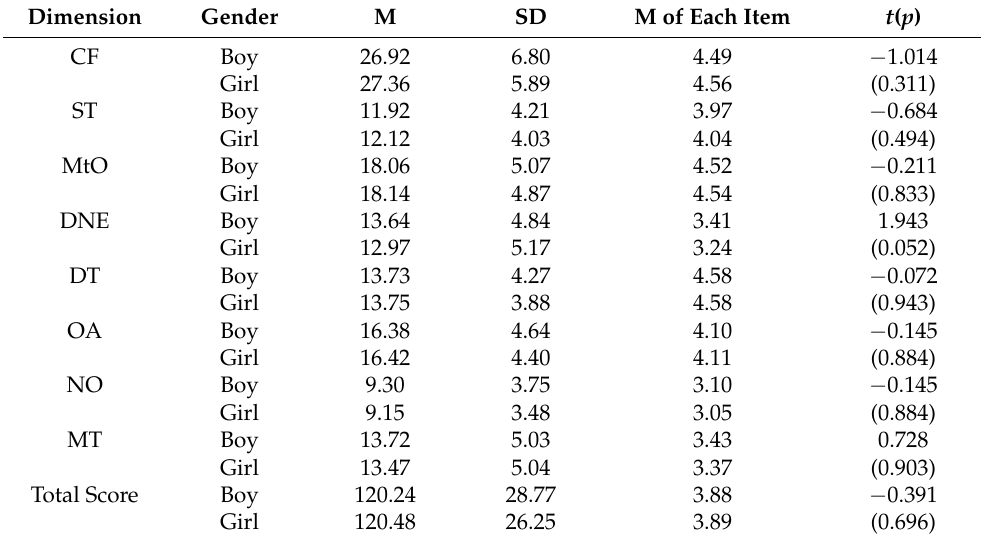
Table 7. The difference in constructive thinking by gender.